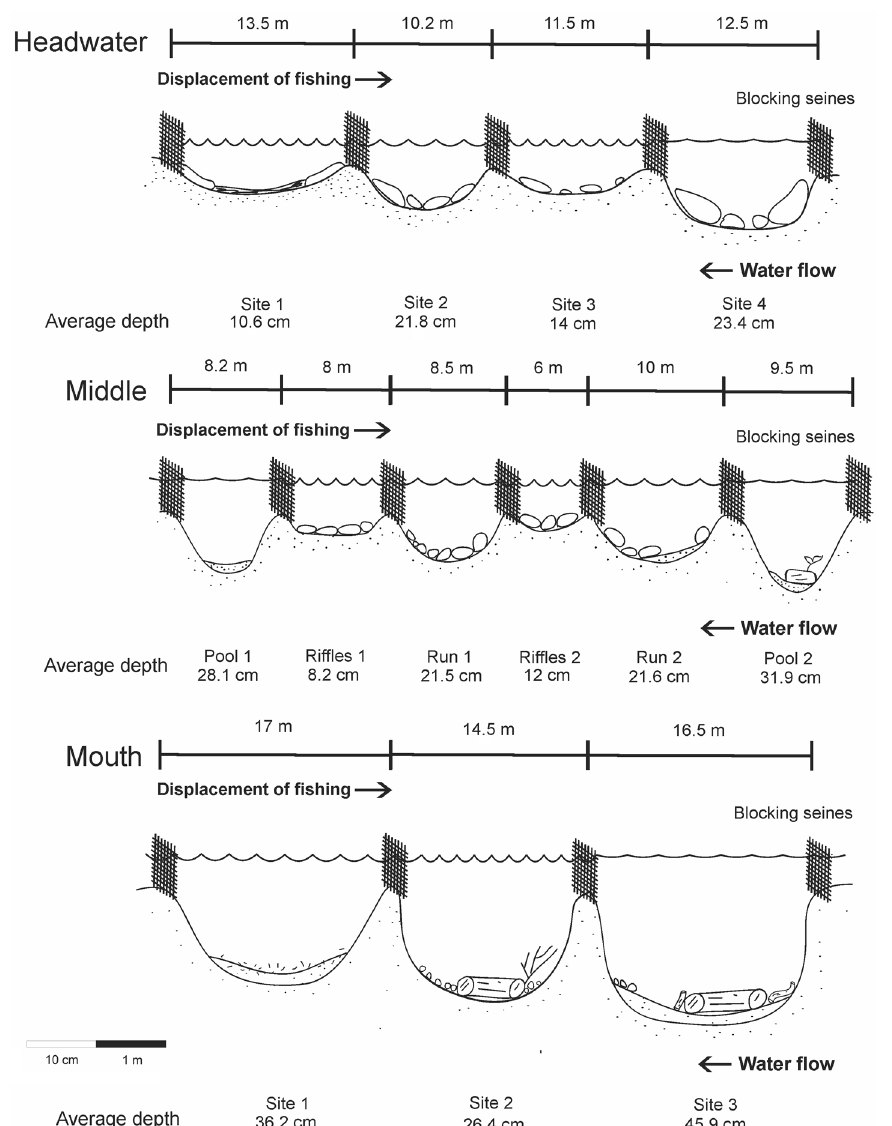
Figure 2. Fish sampling procedure. Length (above) and average depth (below) of each blocked (with seines) sampling site are showed. Middle sites were clustered into mesohabitats (see text). Displacement of fishing indicates the upstream direction of passage of electro- fishing dip nets with